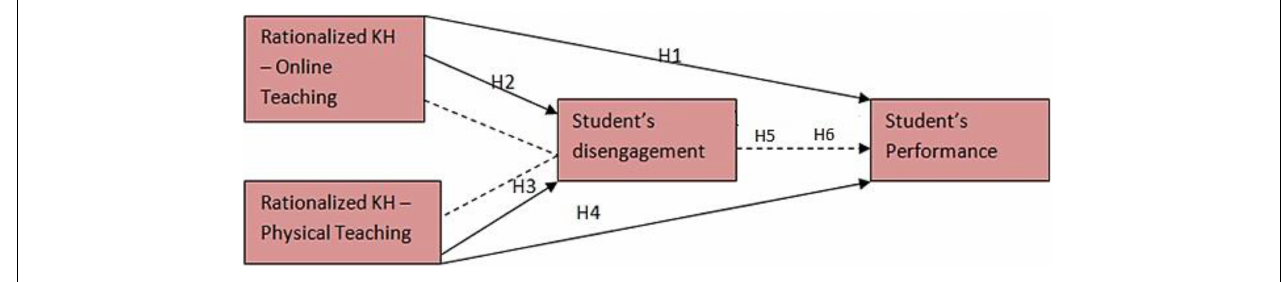
FIGURE 1 | Conceptual